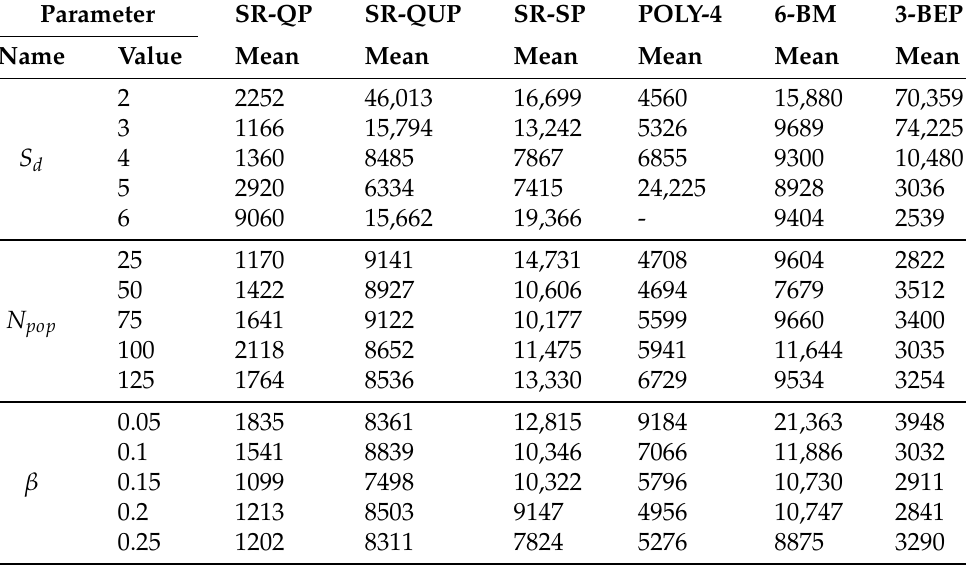
Table 2. ISPLS performance under different values of parameters S d , N pop and β